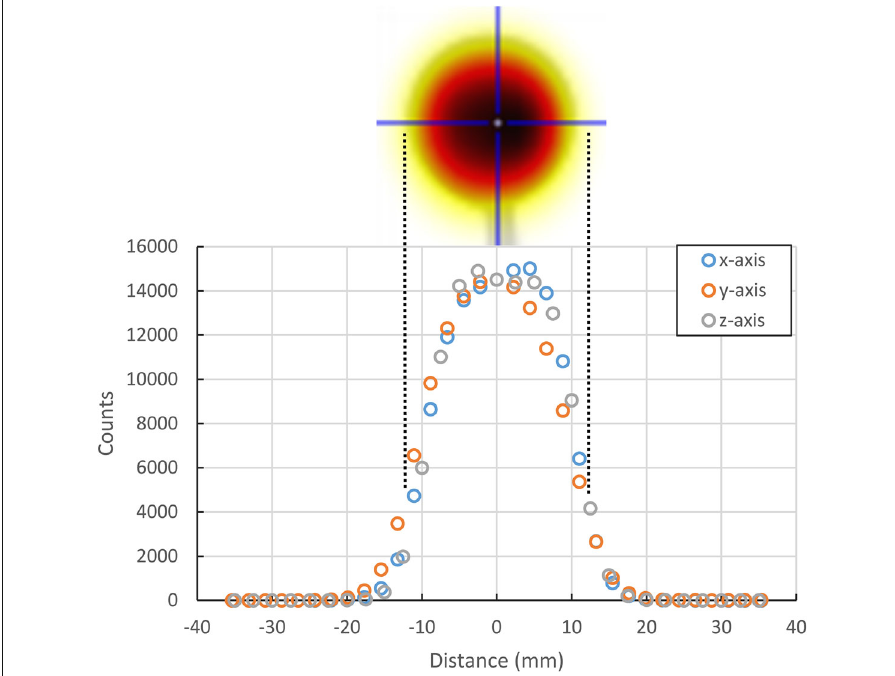
Fig. 5 Quantitative analysis of radioactivity concentration profiles along three perpendicular axes through the 3D printed spherical